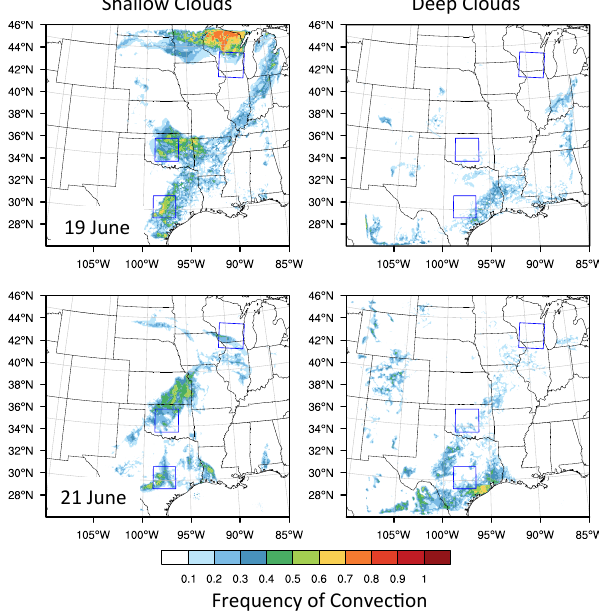
Figure 6. Frequency of occurrence of deep convection (right) and shallow convection (left) for the time period 12:00–20:00UTC on 19 (top) and 21 June (bottom) 2007. ated by the cloud, leading to the frequent periods of miss- ing data below the cloud top (as indicated by the white ar- eas underneath peaks in the aerosol backscatter in Fig.